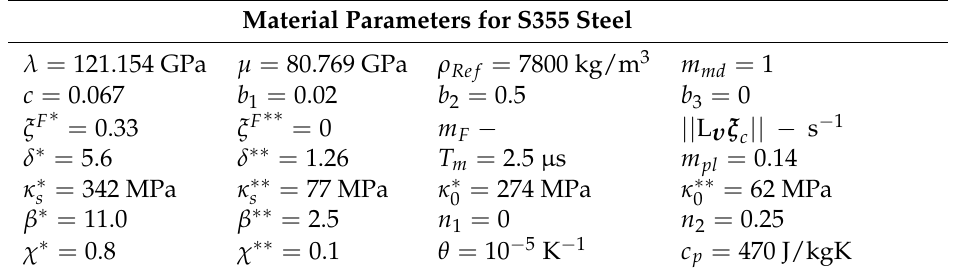
Table 2. Material parameters for steel